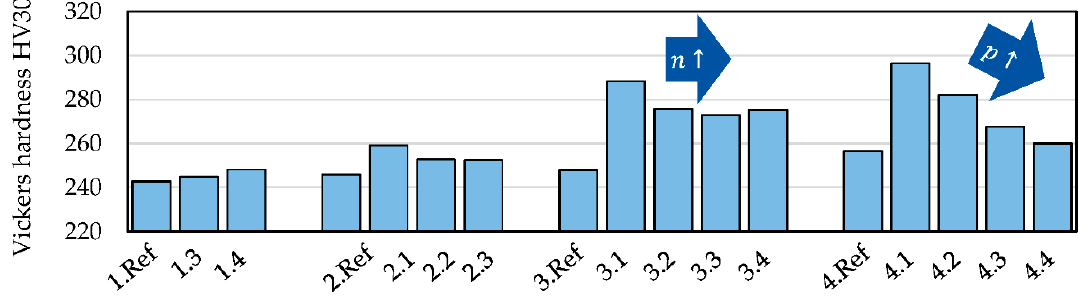
Figure 6. Hardness results. Figure 6. Hardness